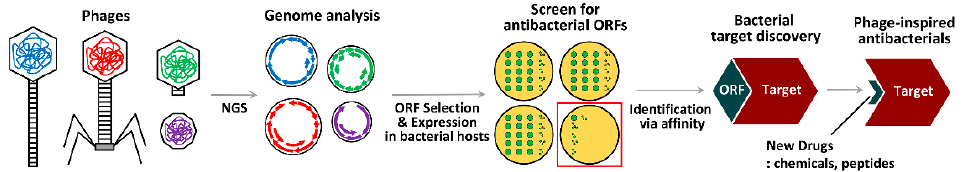
Figure 4. Work flow of phage-inspired antibacterial design. Once phages with strong antibacterial activity are identified, their whole genomes are sequenced and analyzed for open reading frame (ORF) selection. The selected ORFs are expressed in target bacterial hosts to screen for antibacterial activity based on growth or virulence inhibition. Then, the gene product of an ORF hit (dark green) is exploited to fish out the host target based on protein–protein interactions. The discovered host target, the phage-inspired bacterial target, serves as a molecular scaffold for new drug screening. Finally, chemicals or peptides that bind to the host target can be isolated and further developed as phage-inspired